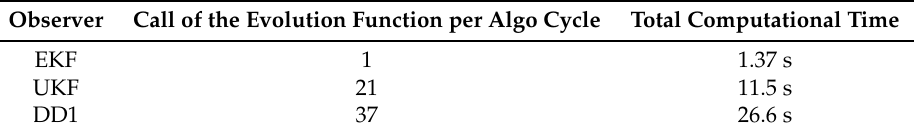
Table 2. Computational load of the filters.